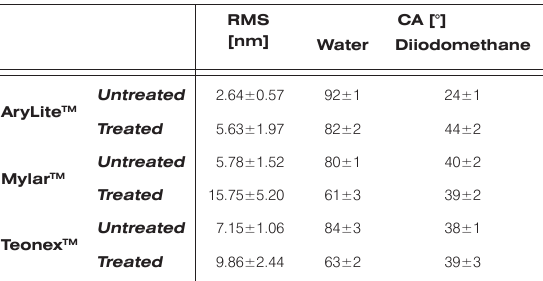
Table 4. Roughness and contact angles of unmodified and treated polyester